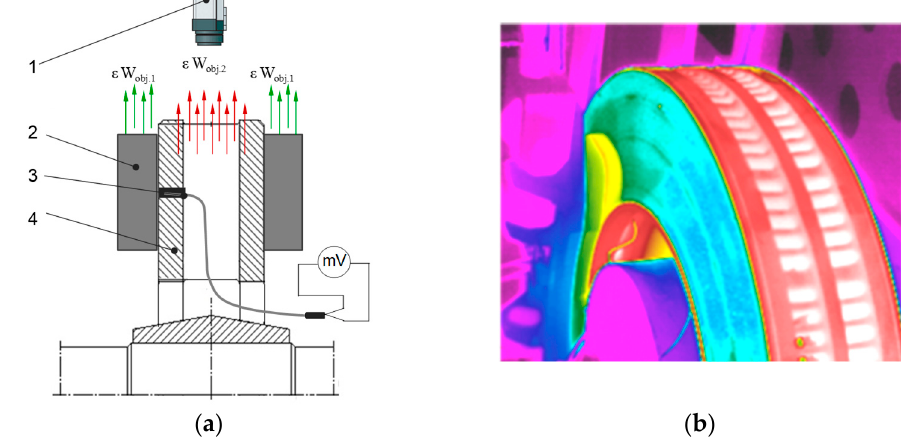
Figure 2. Diagram of thermal imaging test by calorimetric method ( a ), example thermal imaging photo of brake friction pair ( b ); 1—IR camera, 2—friction pad, 3—thermocouple type TP-213K-a-200-200, 4—brake disc, ε —emissivity coefficient, W obj.1,2— radiation acting from object 1 (friction pad) 2 (brake disc) on the detector of the thermal camera.